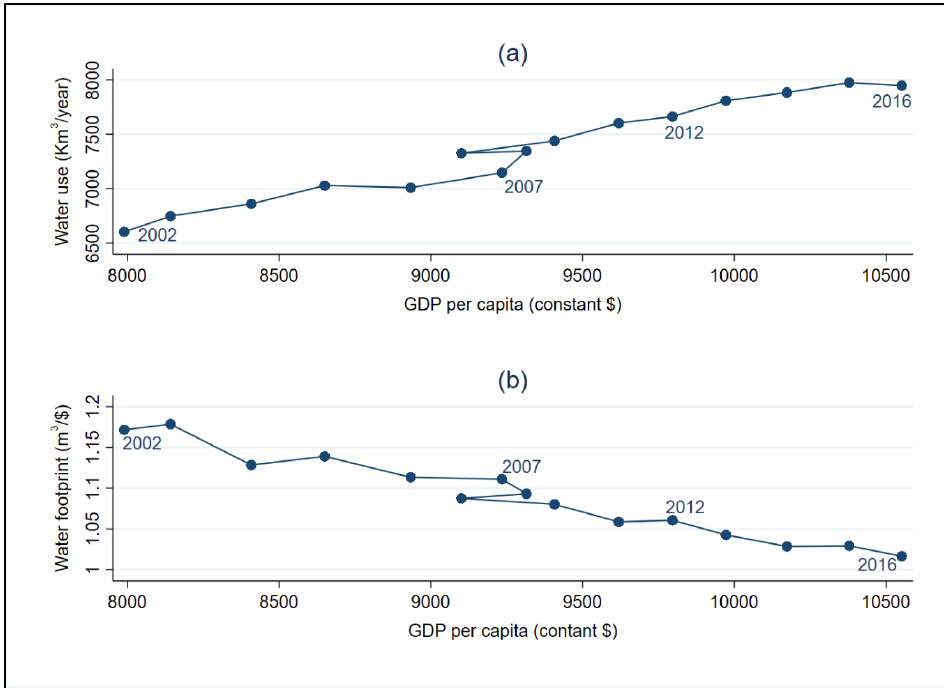
Figure 1. ( a ) Evolution of global arable water use vs. GDP per capita; ( b ) Evolution of global arable WF vs. GDP per capita. Each point in the figure represents, for each year, the combination of GDP per capita and water use or WF at worldwide level. Water use and WF are expressed as the sum of the blue and green component. Data presented in the figure represent only the crop products and the countries covered by this study, so these data may change slightly when considering additional crops and/or countries.